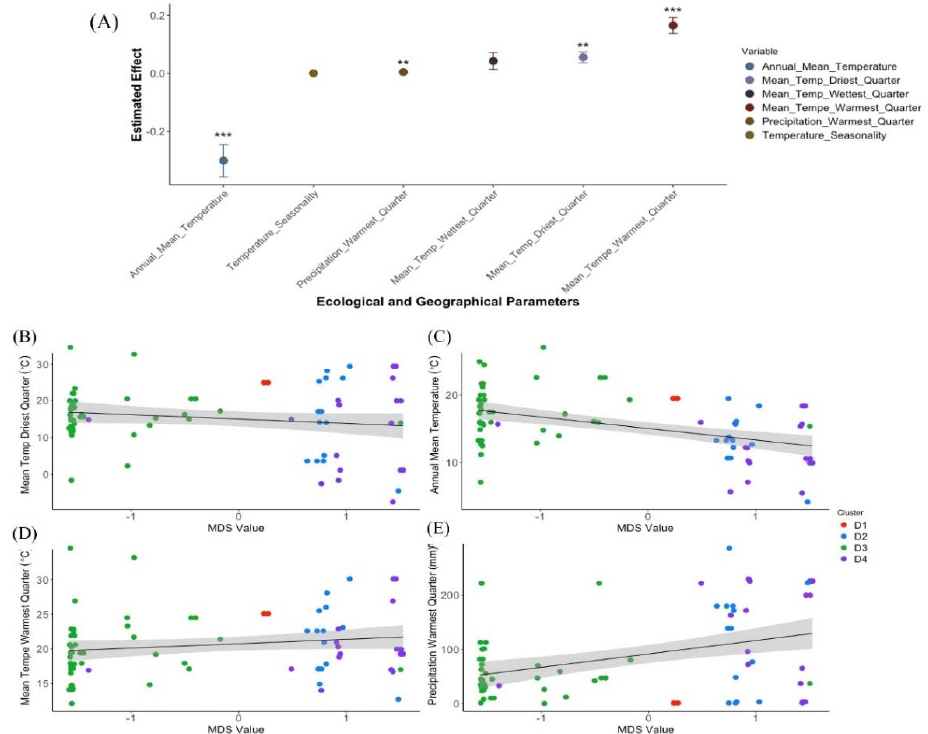
Figure 5. Linear regression models for the effect of ecogeographical parameters on genetic relatedness. ( A ) The estimated effect and the residuals for each of the six parameters included in the linear model,). *** represents the significance level p < 0.0001; ** represents the same p < 0.001. ( B – E ) Scatter plots between the genetic relatedness calculated with MDS and temperature range and precipitation parameters. Each cluster is denoted with a different color.